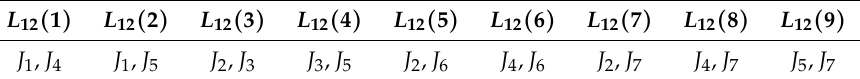
Table 2. Candidates of L 12 and their connecting joints for 6-bar linkage